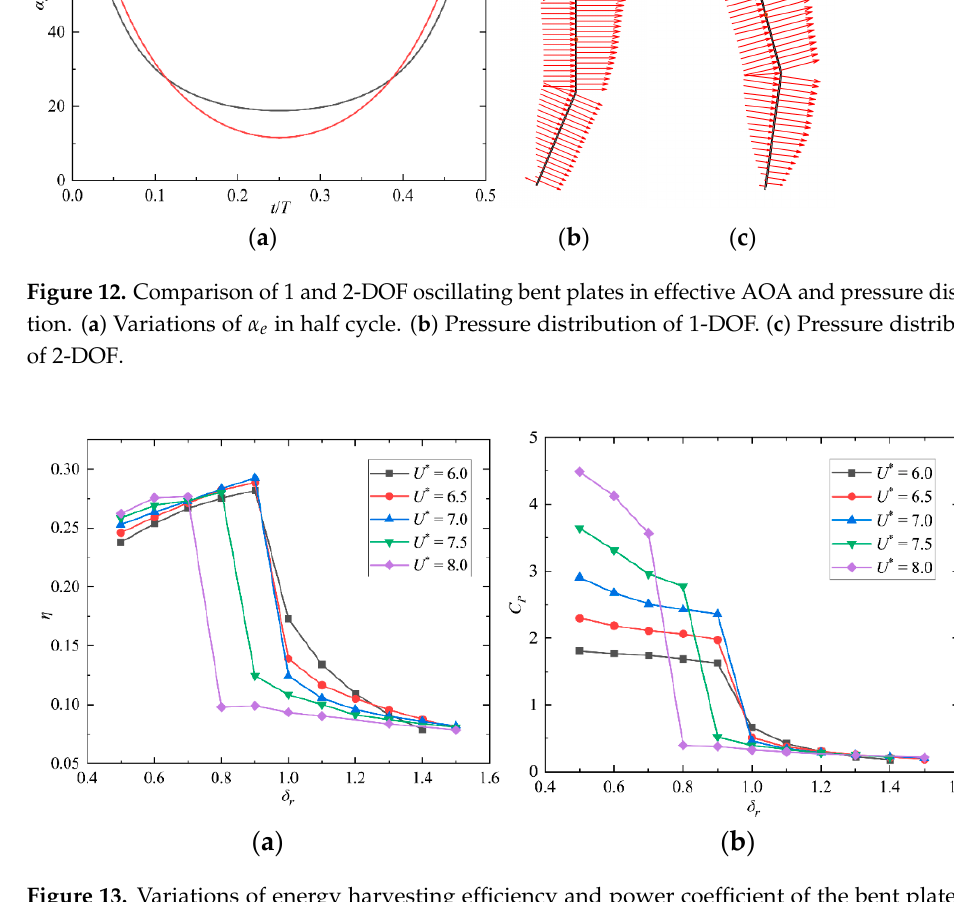
Power coefficient. ( b ) Power